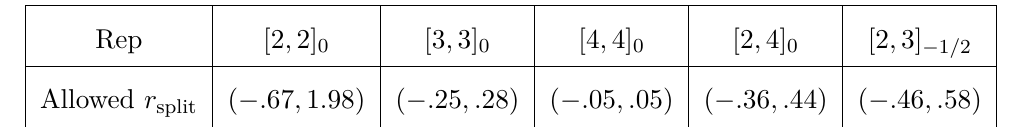
Table 7 . Examples of the magnitude of allowed mass-splitting eq. (2.16) if a particular scalar representation is the only new field contributing to S parameter.